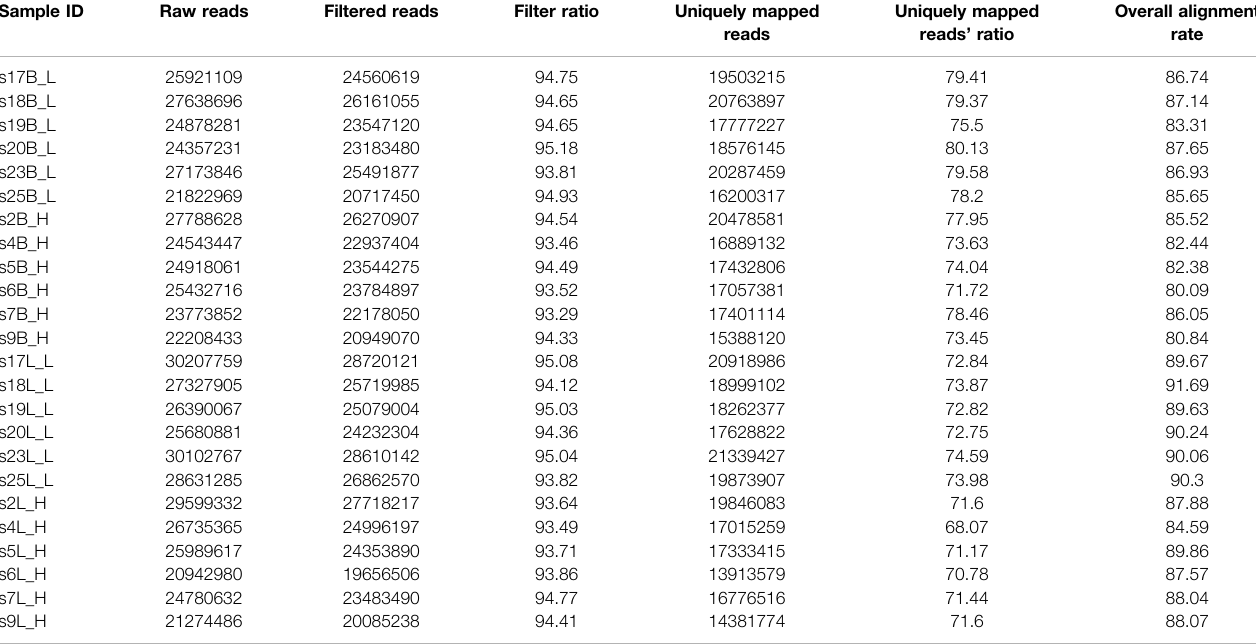
TABLE 1 | Summary of sequencing and mapping statistics for 24 samples used in the study. Sample